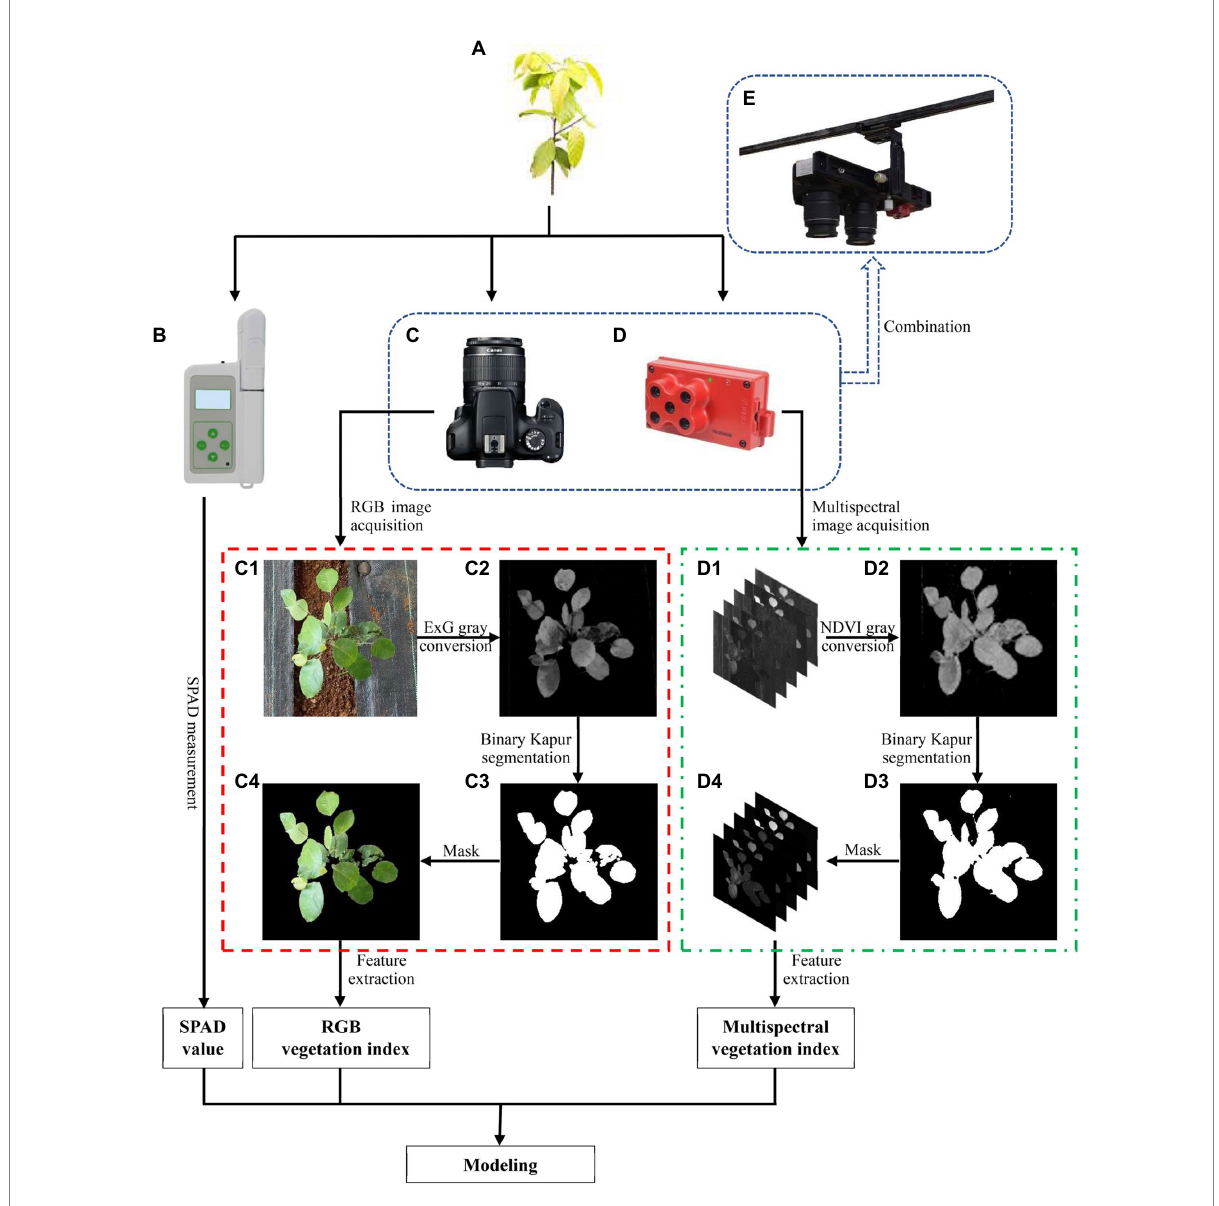
FIGURE 2 Flow chart of data measurement and processing. (A) Hopea hainanensis seedling. (B) Portable plant nutrition meter (TYS-4N). (C) Digital camera (Cannon EOS 4000D). (D) MS camera (MicaSense Edge 3). (E) Combination device of digital camera and MS camera. (C1) Region of interest extracted from RGB image. (C2) Gray image based on ExG conversion. (C3) Binary image after Kapur segmentation. (C4) Mask result of C3–C1. (D1) Region of interest extracted from MS image. (D2) Gray image based on NDVI conversion. (D3) Binary image after Kapur segmentation. (D4) Mask result of